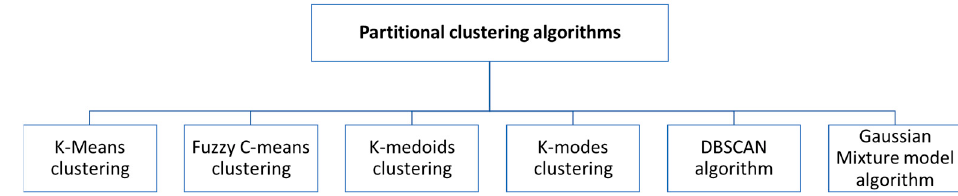
Figure 6. An overview of partitional clustering methods [30].